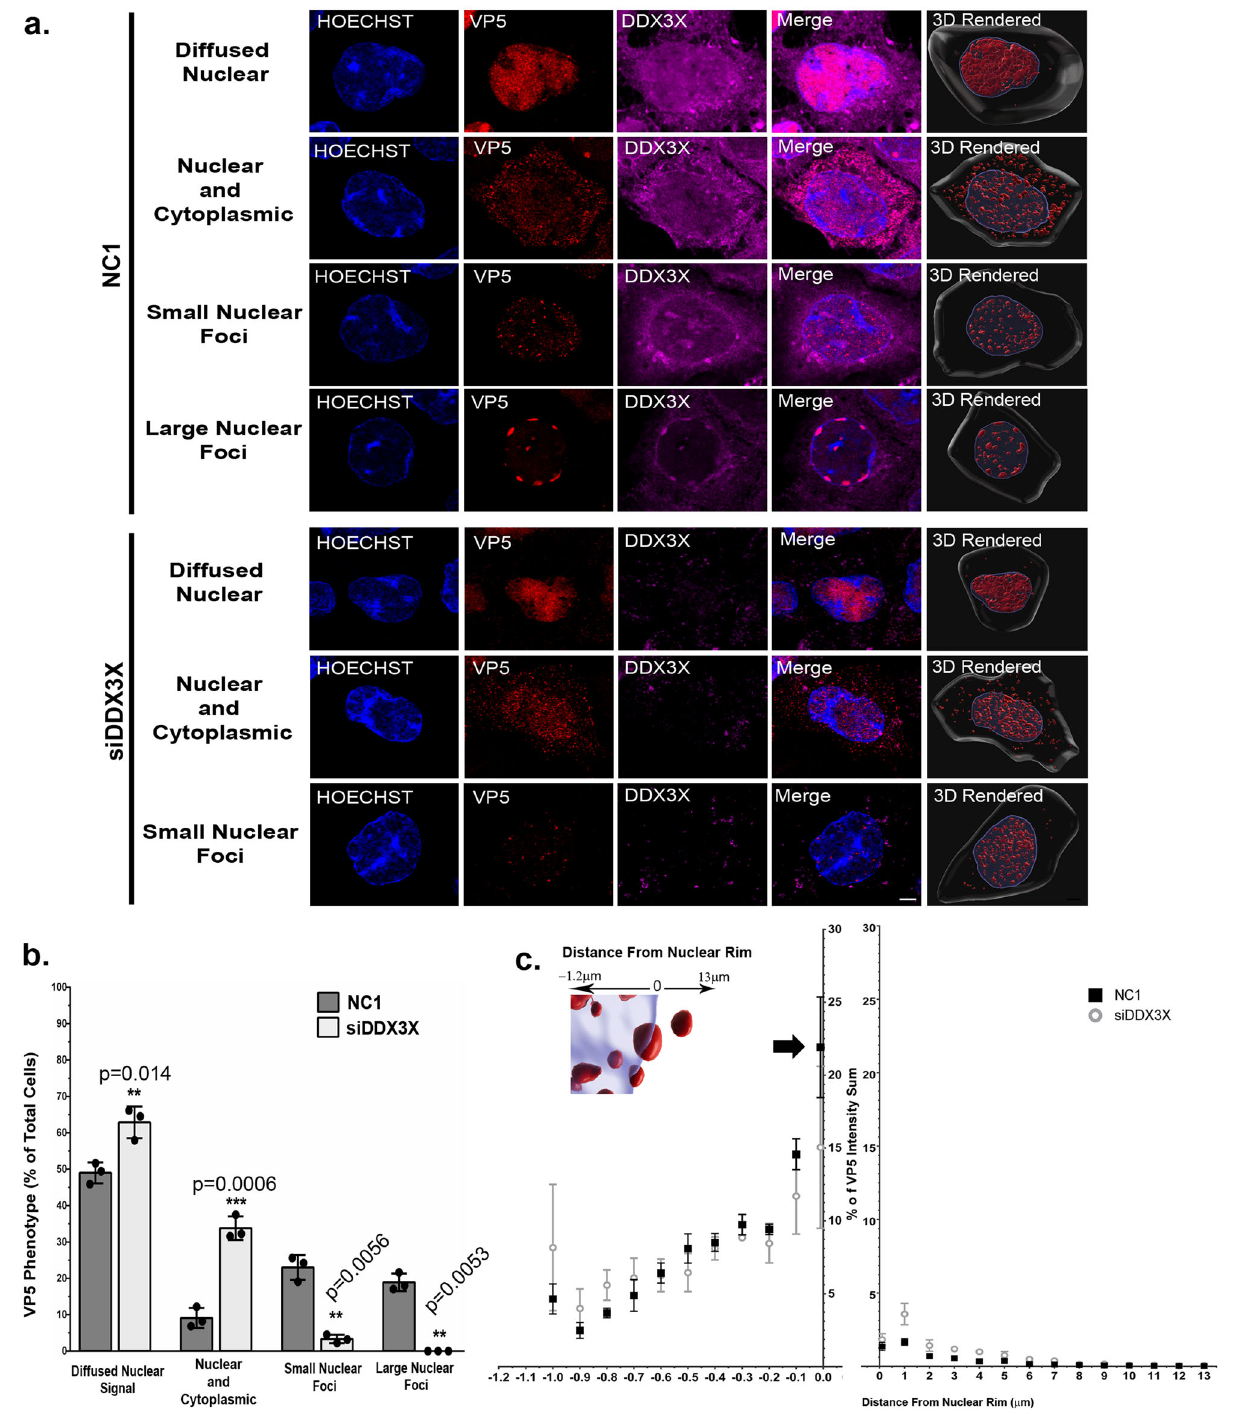
Fig. 5 VP5 fails to concentrate at the nuclear rim in the absence of DDX3X. a HeLa cells grown on coverslips were transfected with 25 nM of siDDX3X or non-targeting control siRNA (NC1) for 48 h. Cells were then infected wild-type strain 17 + virus at an MOI of 5 for 9 hpi. Fixed cells were labelled for DDX3X (magenta) and VP5 (red) and the nuclei stained using Hoechst 33342 (blue). This panel shows representative images of the different VP5 phenotypes observed and their 3D rendered illustrations (see Methods). The rendered images (Z-stacks acquired on a conventional confocal microscope). Scale bar represents 5 µ m. b Eight random images (containing a total of about 200 cells) were analyzed for each condition to quantify the above VP5 phenotype. The bars indicate means and the standard error of the means. Bilateral Student T -tests, ** p < 0.01; *** p < 0.001; NS: not signi fi cant. c Twenty random cells per phenotype (six cells for the less abundant small nuclear foci in siDDX3X treated cells) were analyzed on the Imaris software to compare the distribution of the VP5 signals (% intensity sum) in relation to their distance from the nuclear rim ( µ M). Each point represents the mean of three independent experiments and error bars indicate the standard deviation of the means. So statistical differences were found in c